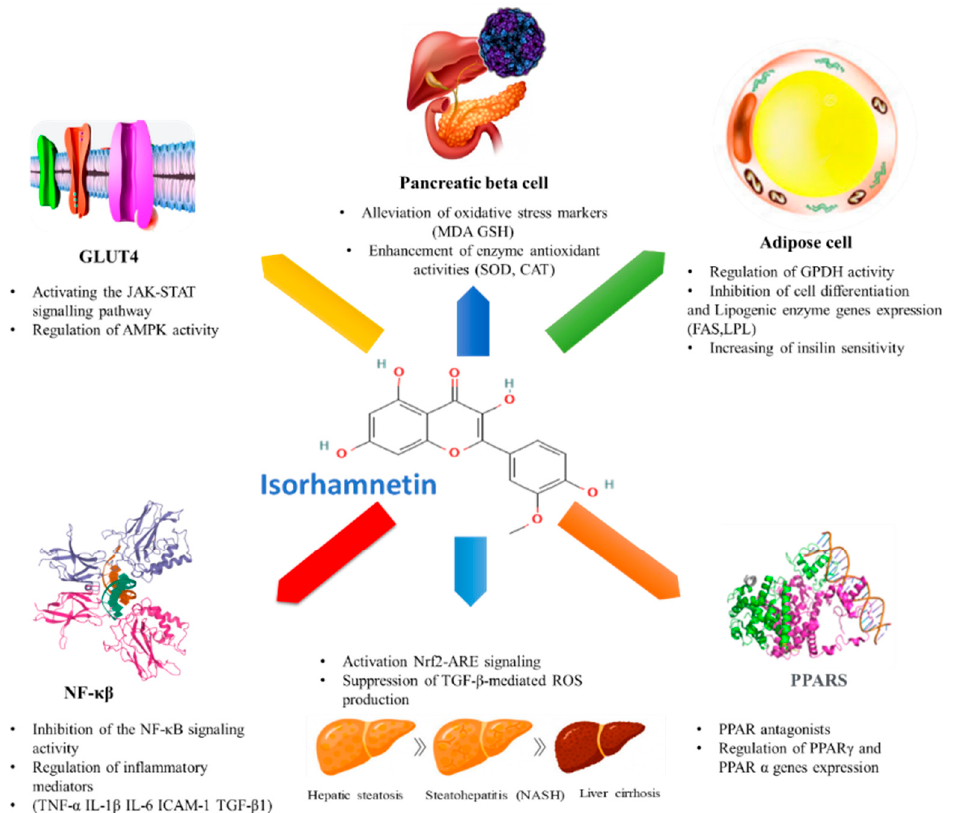
Figure 5. Anti-diabetic effects of isorhamnetin (NF- κβ and PPARS images were downloaded from Protein Data Bank (https://www.rcsb.org/, accessed on 10 November 2021), other images were freely downloaded from free picture database (https://fr.freepik.com/, accessed on 10 November 2021).